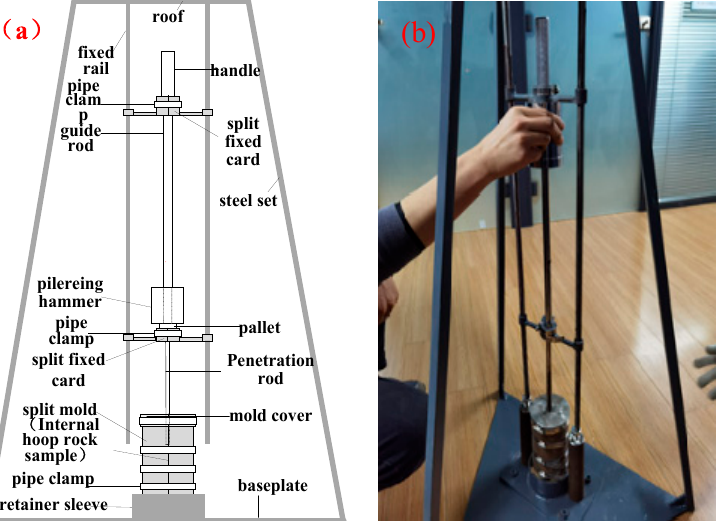
Figure 3. Simulation of the dynamic piling test device: ( a ) schematic diagram; ( b ) object pictures.